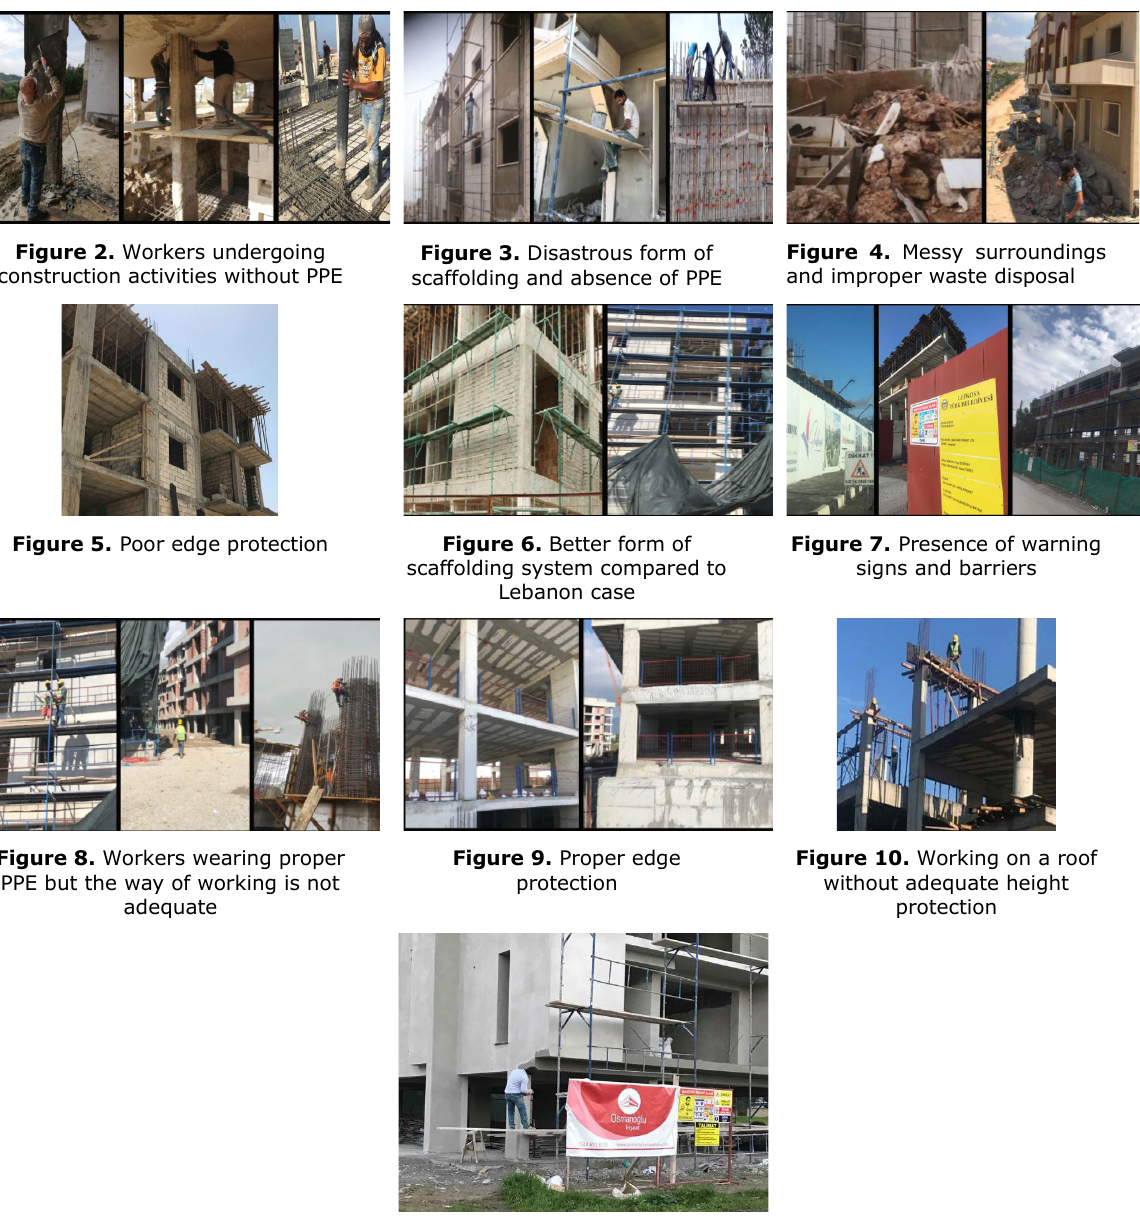
Figure 10. A worker performing plastering without any PPE in a small construction